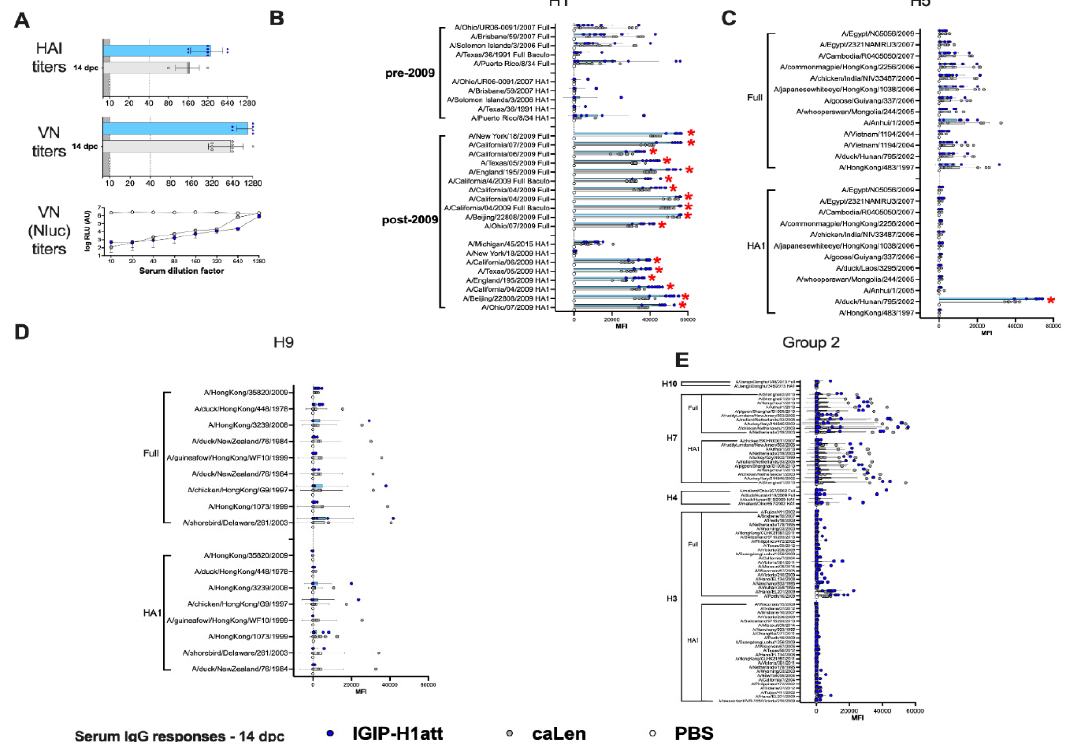
Figure 6. IgG serum responses 14 dpc in IGIP-H1att- and H1caLen-vaccinated mice. Mice ( n = 8/group) were bled at 14 dpc and the sera were collected and used to evaluate antibody titers, as described in Figure 4. IGIP-H1att samples in blue dots/bars. H1caLen samples in grey dots/bars. PBS control samples in white dots/bars. ( A ) HAI, VN, and VN Nluc titers. Levels of IgG antibodies against ( B ) H1, ( C ) H5, ( D ) H9 and ( E ) group 2 HAs. The reactivity of serum samples in main graphs and insets is expressed as described in Figure 4 and results are shown as MFI ± SD. Statistically significant differences between IGIP-H1att and caLen are marked with red asterisks.